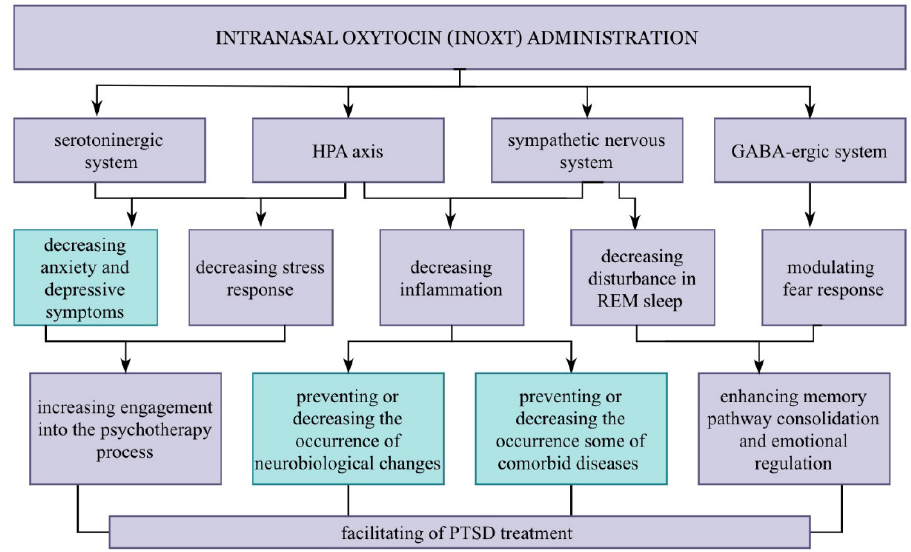
Figure 3. Theoretical relationship between using INOXT and relevant aspects from a PTSD point of view. Intranasal oxytocin (INOXT) administration can induce several potentially beneficial effects for PTSD patients (purple ones) by affecting brain structures. Its properties might facilitate PTSD treatment mainly by affecting memory, including fear extinction memory, and increasing engagement in the psychotherapy process. Apart from that, oxytocin administration might prevent or decrease the occurrence of neurobiological changes or some comorbid symptoms and diseases (teal ones).